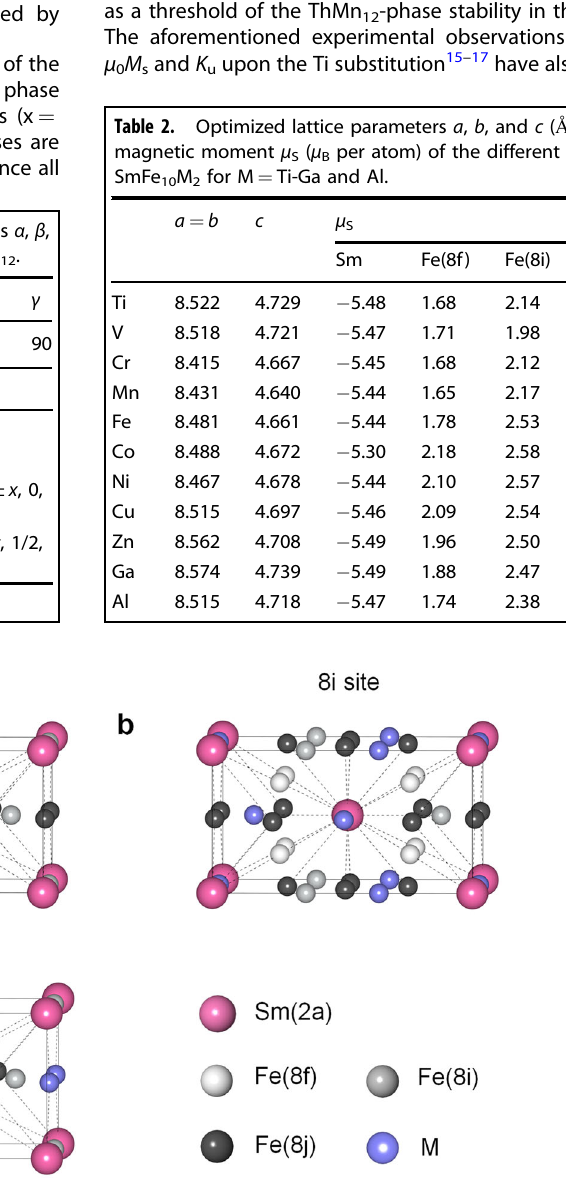
Fig. 1 Atomic structures used for calculations. ThMn 12 -type atomic structures of SmFe 12 − x M x (when x = 2) for the a 8f, b 8i, and c 8j site M substitutes. Only the most stable con fi guration of the distribution patterns of the M atoms is shown for each substitution site.